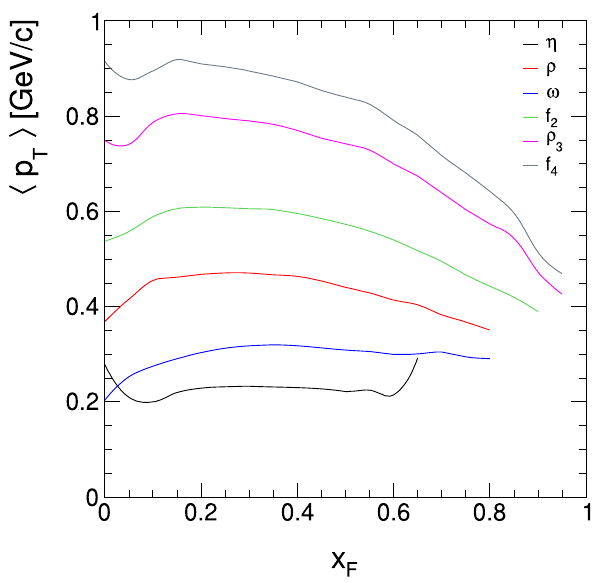
Fig. 192 Mean p T for π − from the decay of mesonic resonances as a function of x F